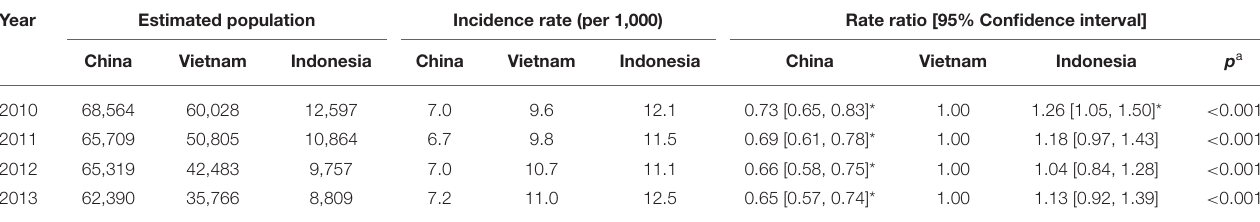
TABLE 3 | The incidence of developmental delays by maternal nationality (Vietnam as the